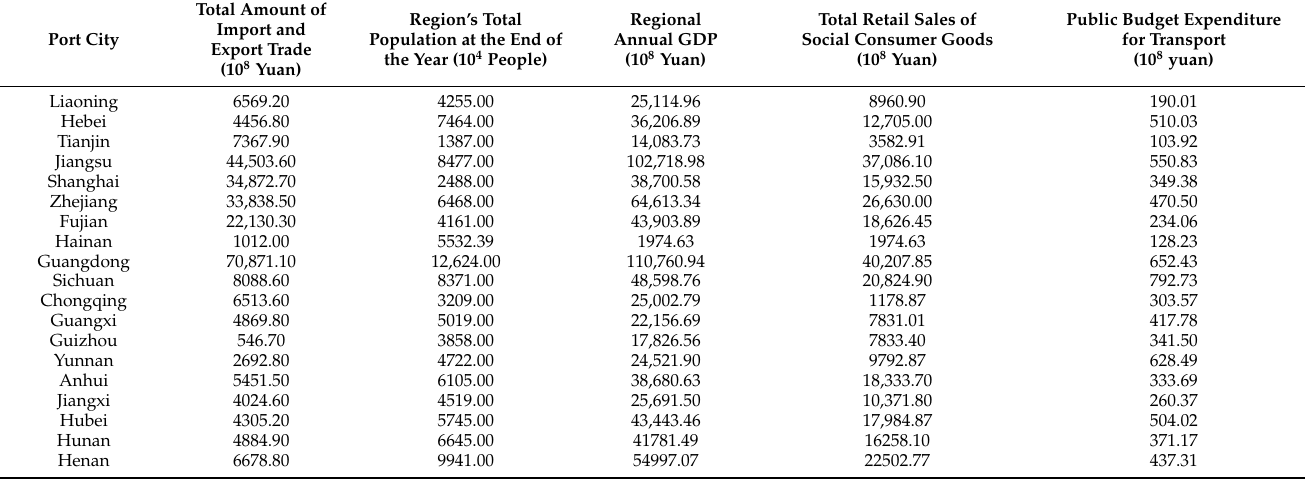
Table A2. The external environmental variables (take 2020 as an